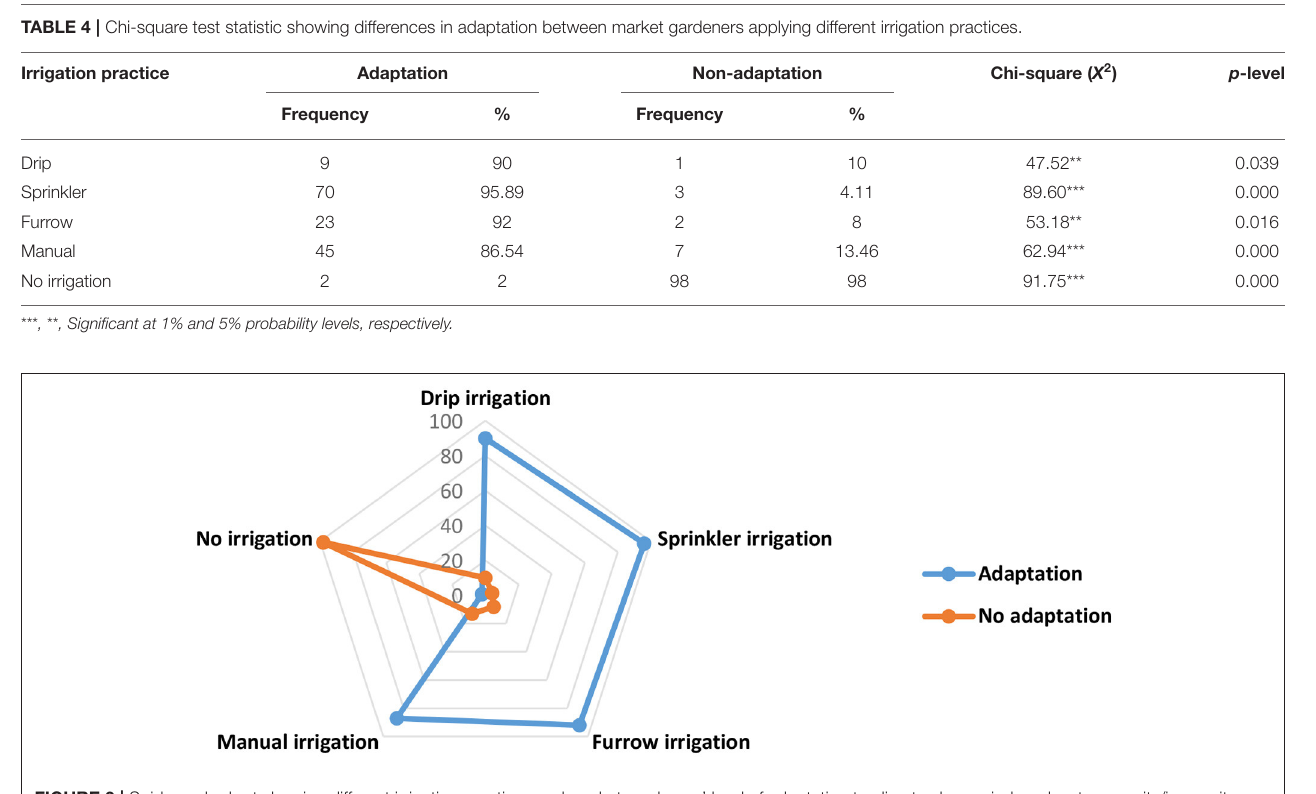
FIGURE 3 | Spider web chart showing different irrigation practices and market gardeners’ level of adaptation to climate change induced water